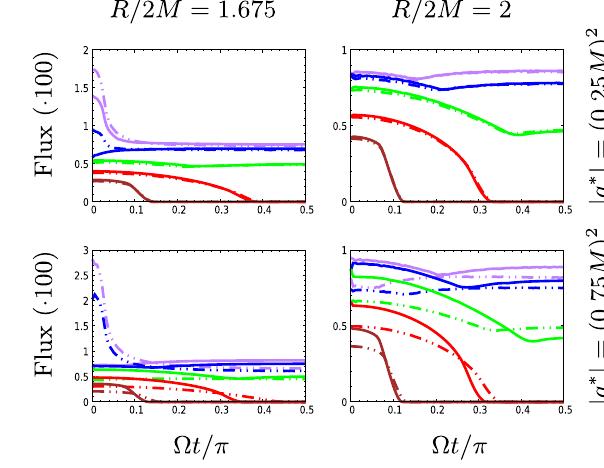
Fig. 6 Pulse profile for single caps. h = 3, ξ = χ = π/ 2. The purple, blue, green, red, and brown lines correspond to (cid:11) = 0 . 00, 0 . 30, 0 . 60, 0 . 90 and 0 . 99 respectively. Solid lines correspond to q ∗ > 0 while dashed lines correspond to q ∗ < 0. In the left column we see the characteristic peak due to the cap in opposition generating multiple images. If the star is not compact enough, the flux goes to zero when the cap leaves the zone of visibility. In the top row, for small values of q ∗ the curves obtained for q ∗ > 0 and q ∗ < 0 are almost identical. In the bottom row, we see that for q ∗ < 0 the initial flux is smaller than for q ∗ > 0 but decays more slowly